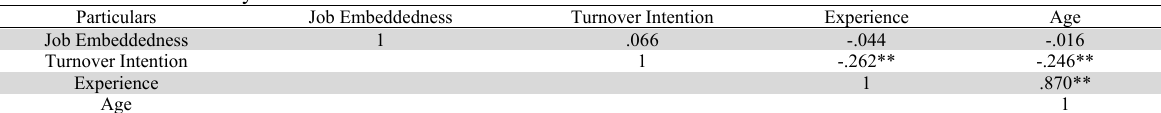
Results of Correlation analysis Particulars Job Embeddedness